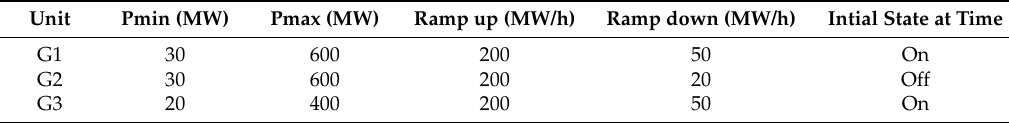
Table 2. Generator data.